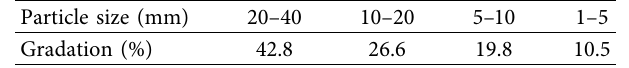
Table 1: Coarse aggregate